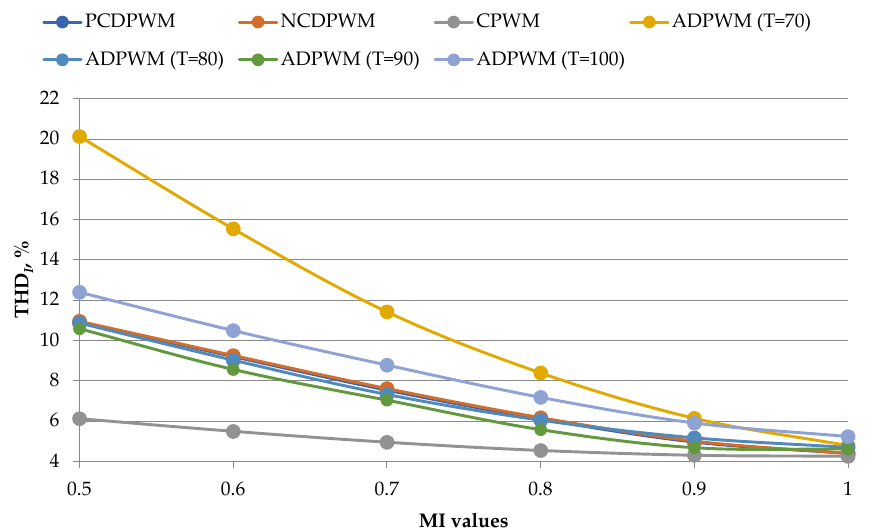
Figure 11. THD I on MI dependence for the proposed ADPWM method and other PWM strategies at various inverter radiator temperatures.